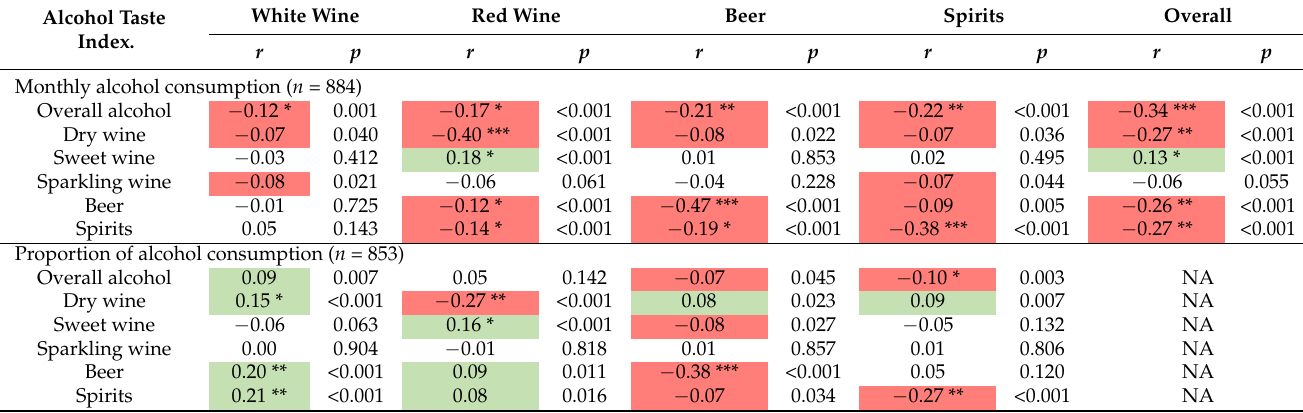
Table 2. Correlation between alcohol taste statement indices and measures of alcohol consumption by beverage type (overall, white wine, red wine, beer, and spirits). Correlation coefficients ( r ) are shaded in green and red to highlight significant positive and negative correlations, respectively. Effect sizes were considered small (*), medium (**), or large (***) when absolute r values exceeded 0.1, 0.2, or 0.3, respectively [59]. (NA = “not applicable”). Alcohol Taste Index.